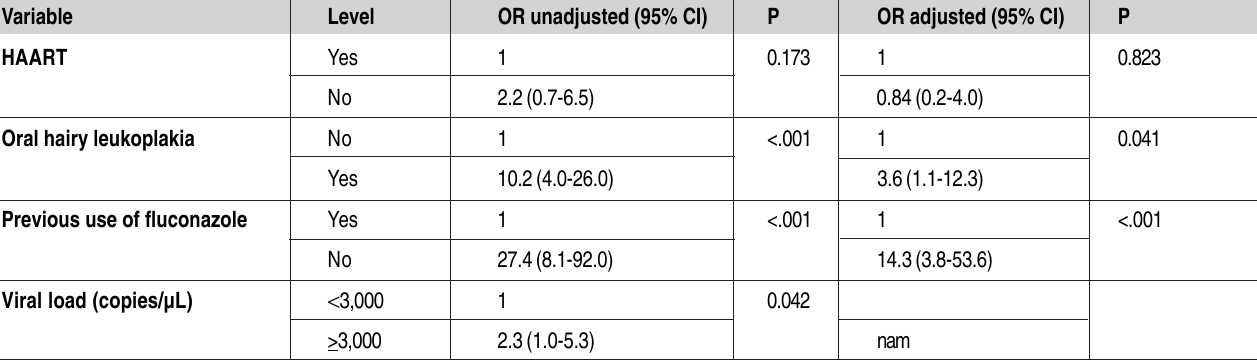
Table 2. Unconditional simple and multiple logistic regression analysis between independent variables and oral candidiasis (final model) among 112 HIV/AIDS patients attended at the CTR-DIP, Belo Horizonte, MG, Brazil, during 2002 to 2004